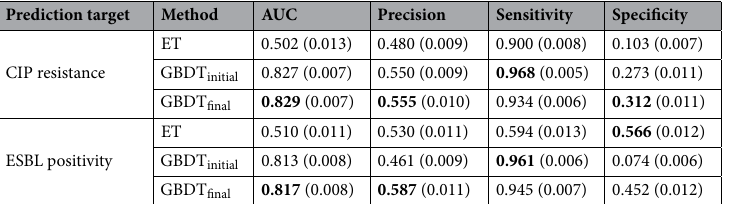
Table 3. The classification performance of the prediction models compared with the empirical treatment (ET). The initial GBDT model used all predictors and its decision threshold was set to 0.300. The final GBDT model used the reduced number of predictors and its decision threshold was set to 0.335. 95% confidence intervals (values in parentheses) were obtained by bootstrap analysis. Values in bold are the highest value across the different methods for the same